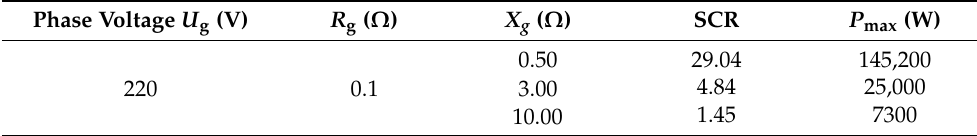
Table 1. Parameters of systems of three grid strengths.